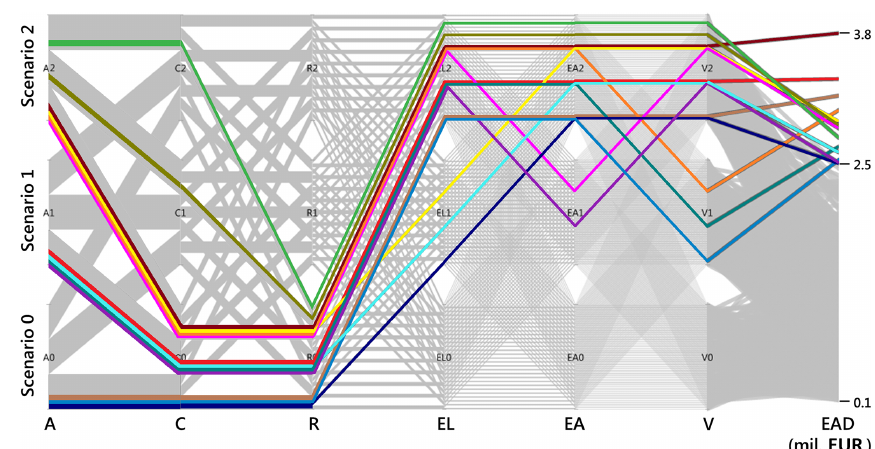
Figure 9. Parallel-coordinate plot showing combinations of flood risk components that result in a certain EAD interval. From left to right, the six parallel coordinates represent changes in the flood risk components (A, C, R, EL, EA, and V), and the parallel coordinate on the right-hand side shows EAD (million EUR) obtained from different combinations of risk component scenarios. Change scenarios are indicated by 0, 1, and 2 on the parallel coordinates. Each highlighted scenario is represented by a different colour.